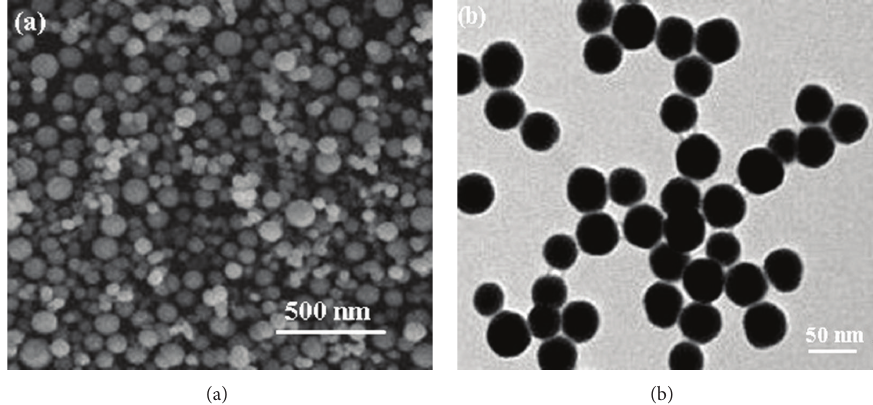
Figure 2: (a) SEM and (b) TEM images of ZnS nanospheres.